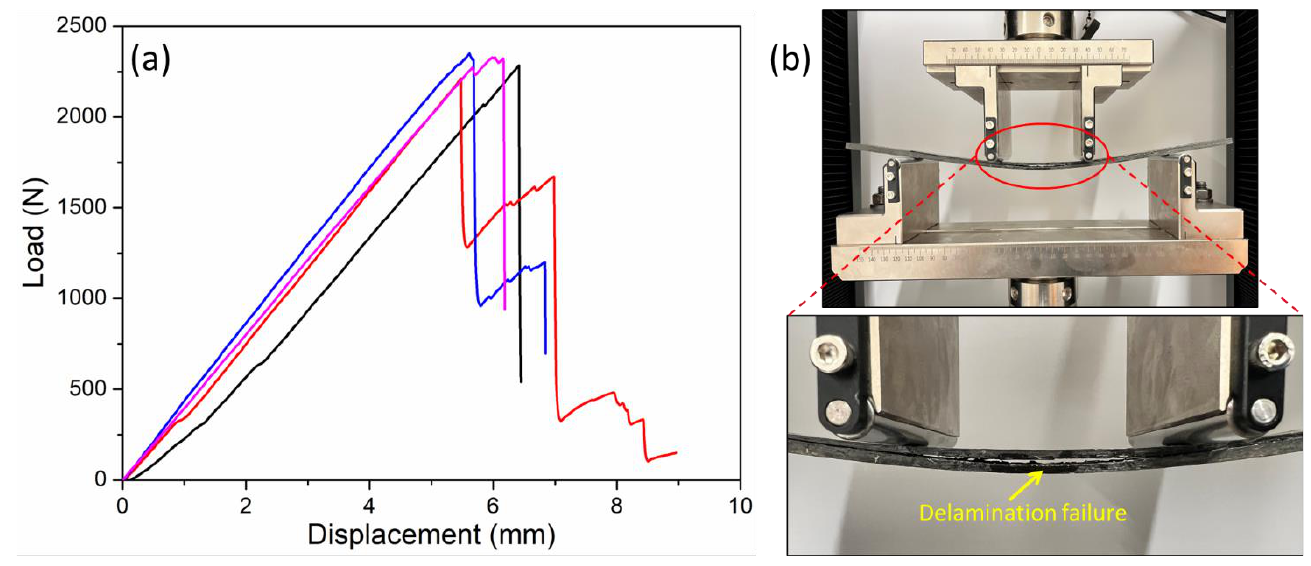
Figure 9. ( a ) Load vs. displacement curves for the pristine specimens and ( b ) repaired composite laminates under four-point bending tests. Table 3. Average flexural properties of the pristine and repaired specimens.